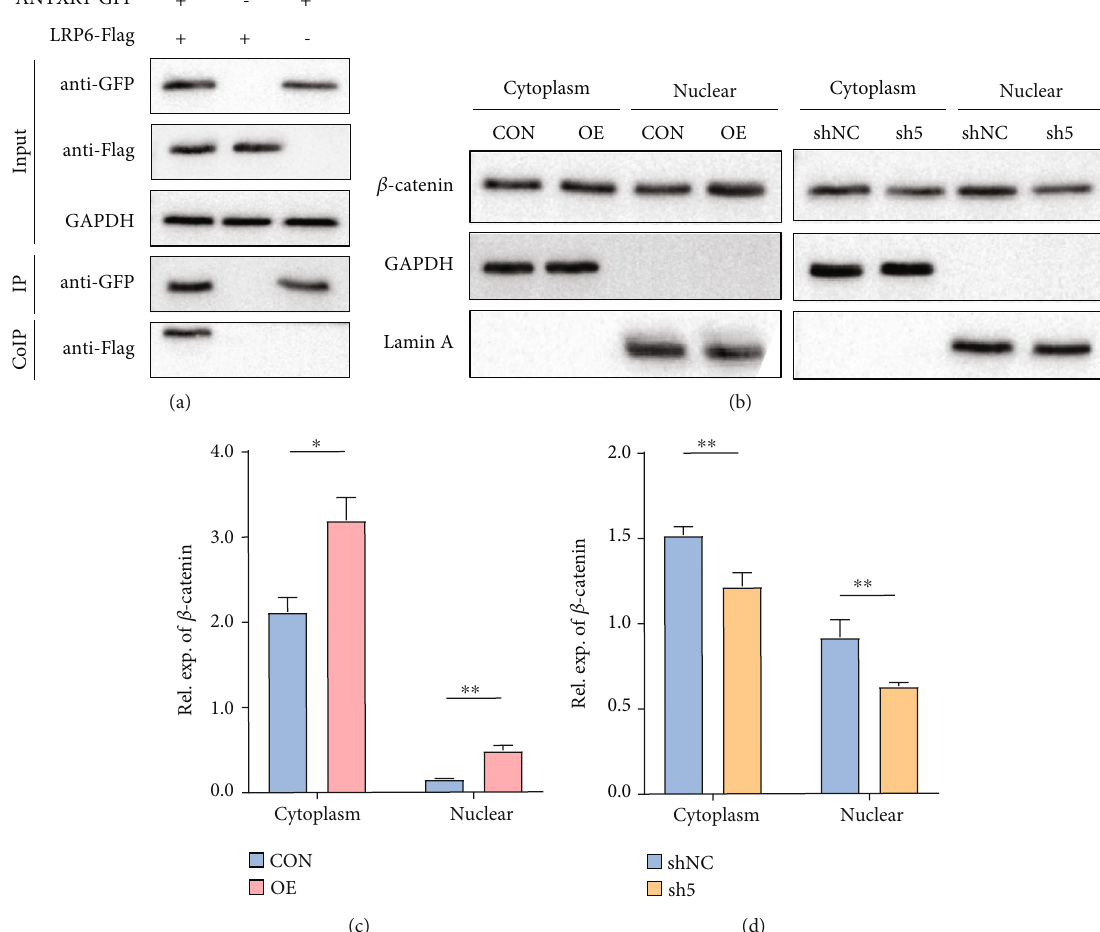
Figure 3: ANTXR1 activates the Wnt/ β -catenin signaling pathway by promoting β -catenin into the nucleus. (a) ANTXR1 interacted with LRP6 shown by the Co-IP assay that the lysates from the K562 cells transfected with the ANTXR1 – GFP and LRP6-Flag plasmids by using GFP- and Flag-targeting antibodies. (b) β -Catenin expression in the cytoplasm and nucleus was detected by western blot analysis after K562 cells were transfected with the ANTXR1 vector, control vector, ANTXR1-shRNA vector, or NC-shRNA vector. (c, d) Quanti fi cation of western blots. The error bar represents the SD. ∗ P < 0 : 05 and ∗∗ P < 0 : 01 . NC designates the negative